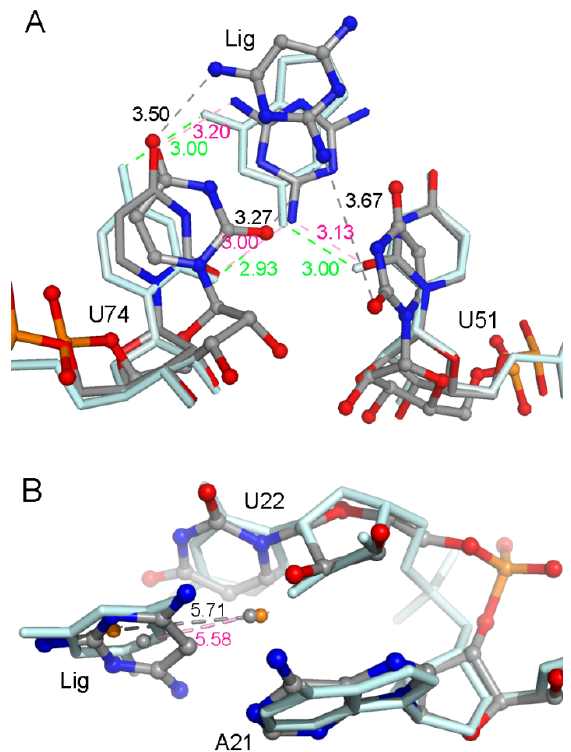
Table 2. The average root-mean-square deviations (RMSDs) of the key six nucleotides (Å).